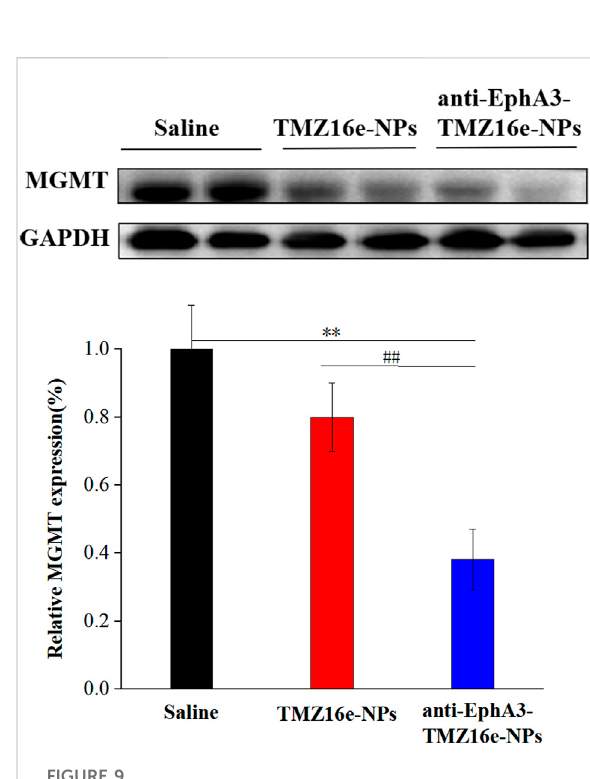
FIGURE 9 The protein expression level of MGMT and GAPDH in the brain sections of tumor-bearing nude mice treated with TMZ16e- NPs and anti-EphA3-TMZ16e-NPs ( n = 2), ** p < 0.01 versus saline, ## p < 0.01 versus